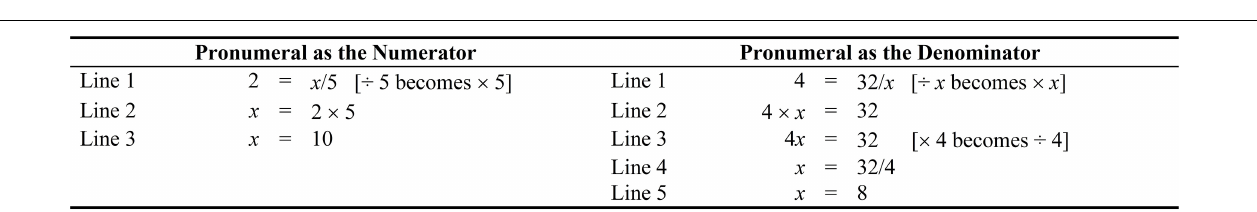
FIGURE 5 | A comparison between solution procedure of two types of trigonometry problems.